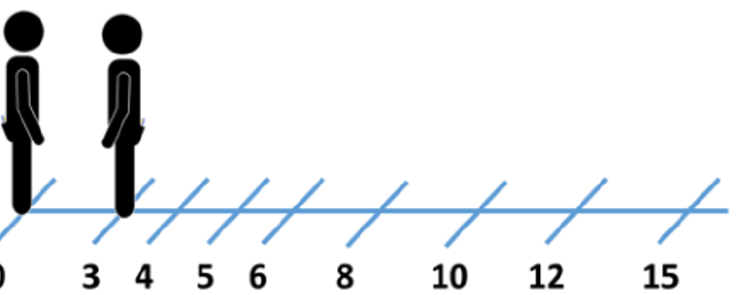
Figure 1. Eight distances for measurements of the RSSI database (source: PACT website). HANNARA is a Korean Maritime and Ocean University student training ship.